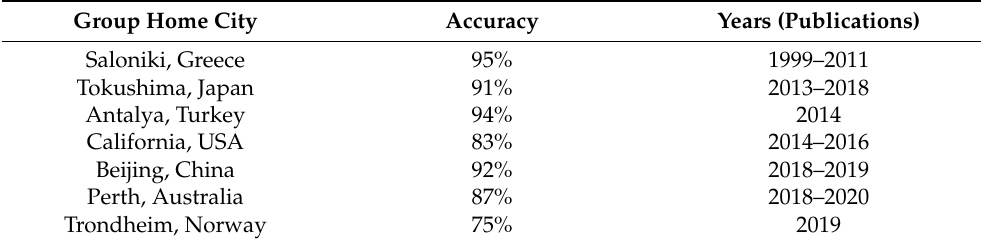
Table 2. Accuracy of bowel sound identification methods developed by selected groups from around the world, demonstrating successful application of diverse approaches. However, accuracy reported by teams based in the cities listed cannot be directly compared because of largely different recording techniques, datasets and definitions of bowel